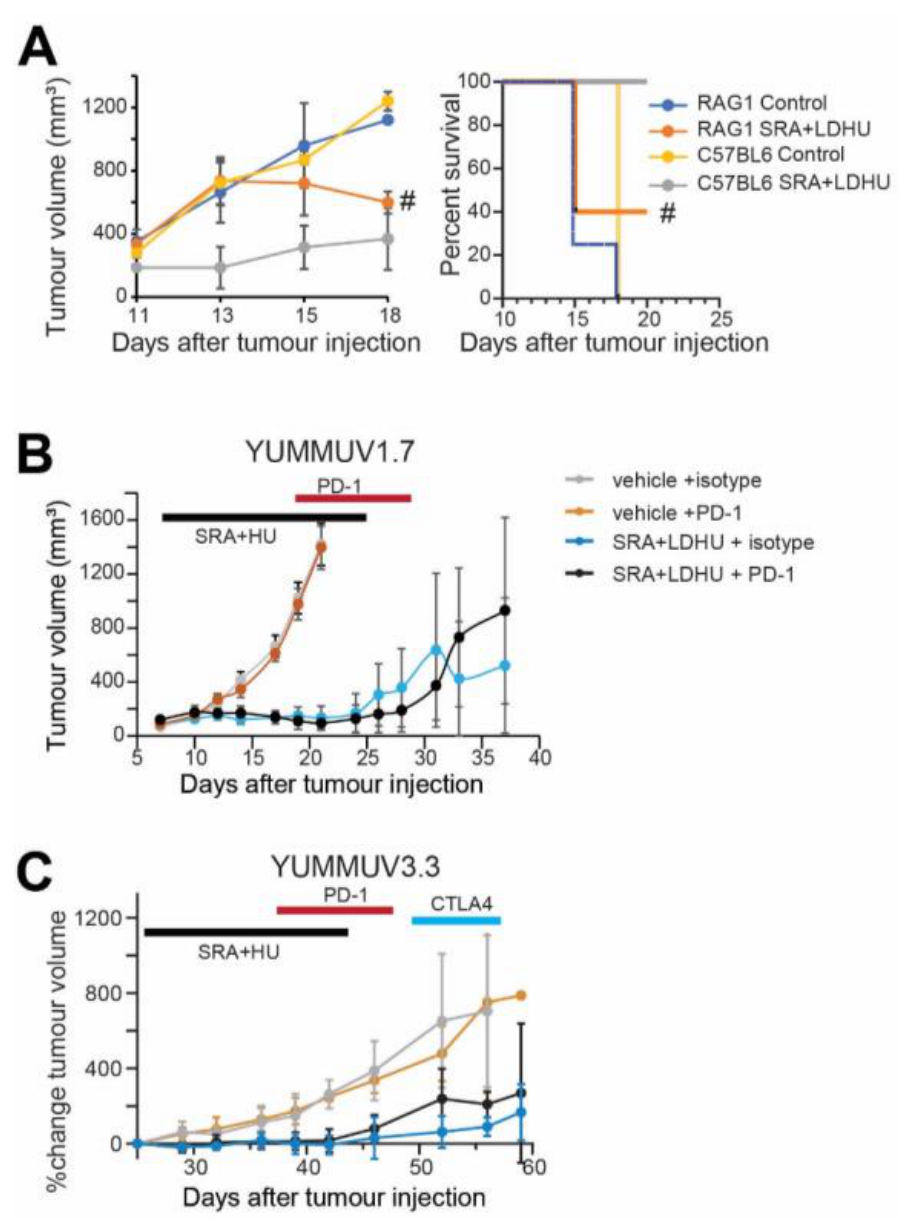
Figure 6. Tumour growth curves for CHK1i+LDHU ± immune checkpoint inhibitor-treated tumour- bearing mice. ( A ) YUMMUV1.7 tumours were established in Rag1 − / − (five mice/group) and immune-competent C57BL/6J (three mice/group) mice then treated from day 11 with SRA737+LDHU as previously. Tumour size was monitored. # indicates tumour size of the two remaining mice after three had reached ethical size limits (>1 cm 3 ). Kaplan–Meier curve of the same experiment. ( B ) YUMMUV1.7 tumour bearing mice either without or with CHK1i+LDHU treatment, then treated with either isotype IgG or anti-PD-1. The data are for groups of 4–5 mice. The periods of treatment are indicated. ( C ) Similar data for YUMMUV3.3 mice expressed as percentage change from immediate pre-treatment volume. The individual mouse tumour growth is shown in Figure